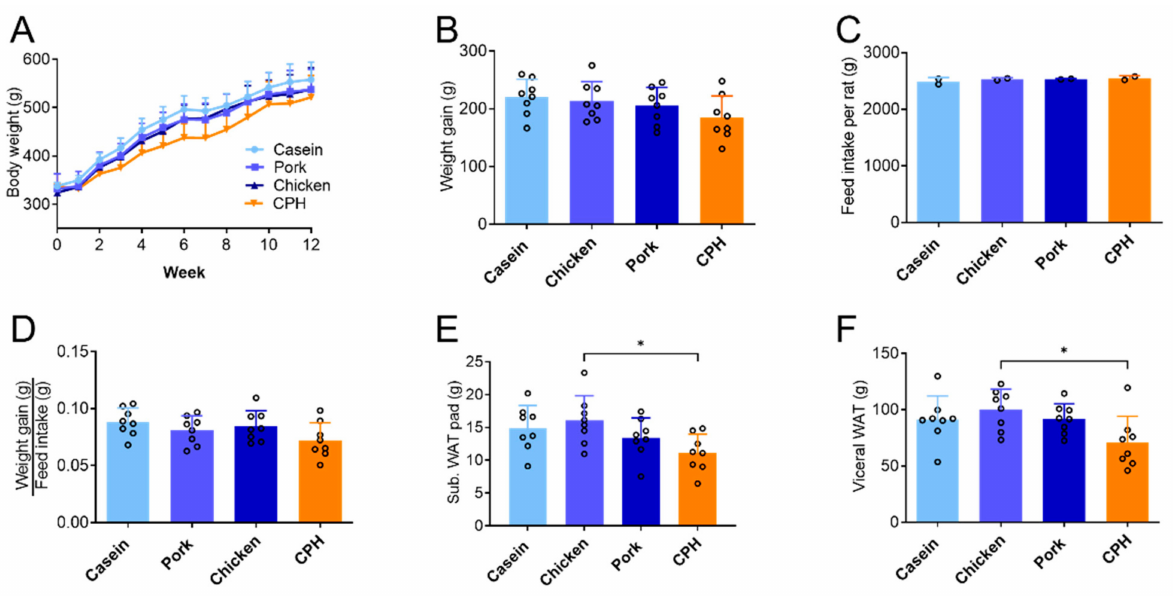
Figure 1. Body weight and feed intake in Wistar rats fed high-fat diets with different protein sources for 12 weeks, either casein, chicken meat, pork meat, or hydrolyzed chicken protein (CPH). ( A ) Body weight per rat, mean +/ − SD are shown ( n = 8). ( B ) Total weight gain per rat during the study, mean +/ − SD are shown ( n = 8). ( C ) Total feed intake per rat measured throughout the study. Mean values were based on average feed intake per rat per cage ( n = 2). ( D ) Feed efficiency was based on total weight gain per rat divided by average feed intake per rat per cage ( n = 2). ( E ) Subcutaneous WAT depot weights, mean +/ − SD, are shown ( n = 8). ( F ) Sum of weights of epididymal/gonodal WAT depots, perirenal WAT-depots and the mesenteric WAT depot, mean +/ − SD are shown ( n = 8). Individual values are indicated by circles Significant difference was determined by one-way ANOVA with Tukey’s multiple comparisons test between all diet groups (* p <